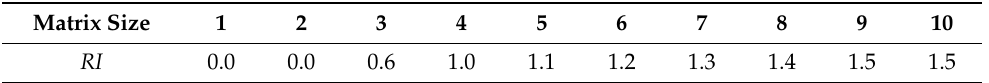
Table 5. Values of Random Consistency Index.